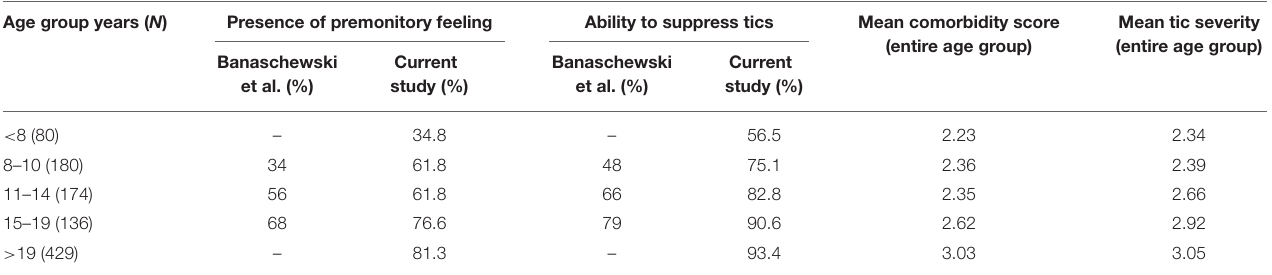
TABLE 7 | PU, tic suppression, comorbidity score, and tic severity* compared to results provided by Banaschewski et al. (2003). Age group years ( N